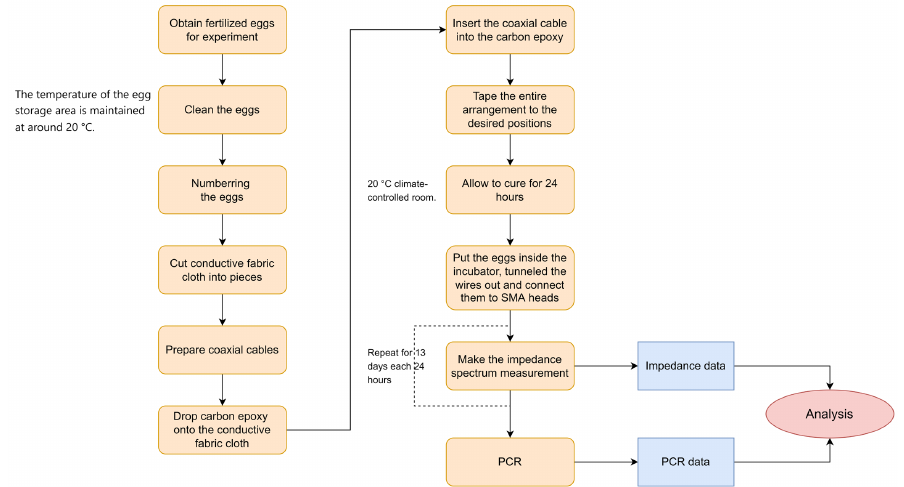
Figure 4. Experimental flowchart for impedance measurement and data